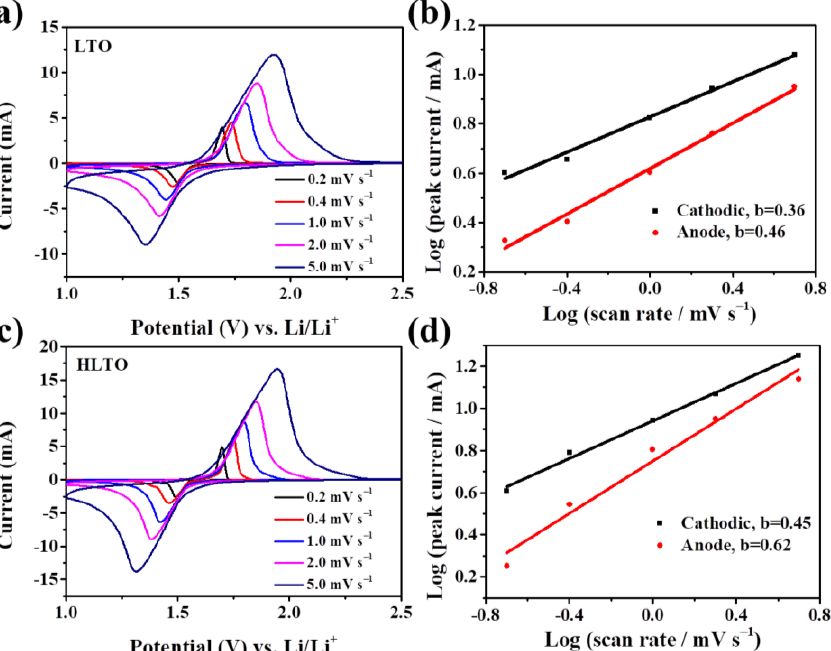
Figure 6. Kinetic analysis of the LTO and HLTO anodes: ( a ) CV curves at different scan rates for LTO and ( b ) corresponding log i versus log v plot; ( c ) CV curves at different scan rates for HLTO and ( d ) corresponding log i versus log v plot.